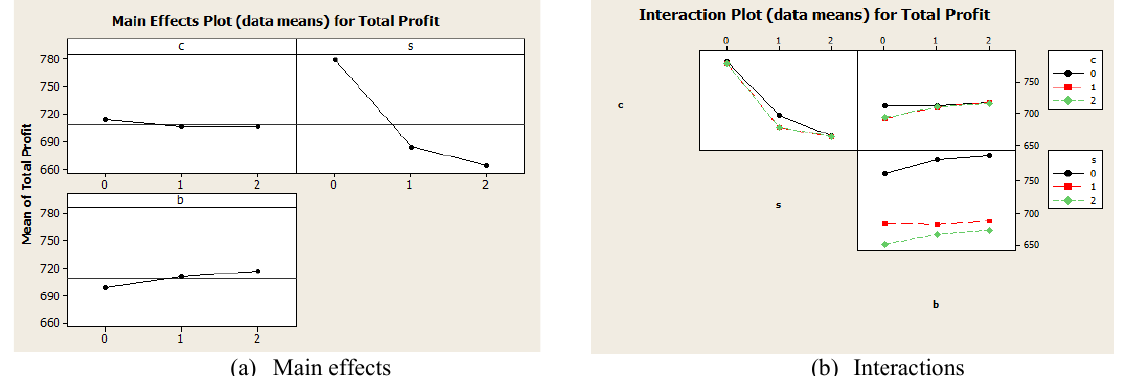
Fig. 9. Main effects and interactions plot for the total